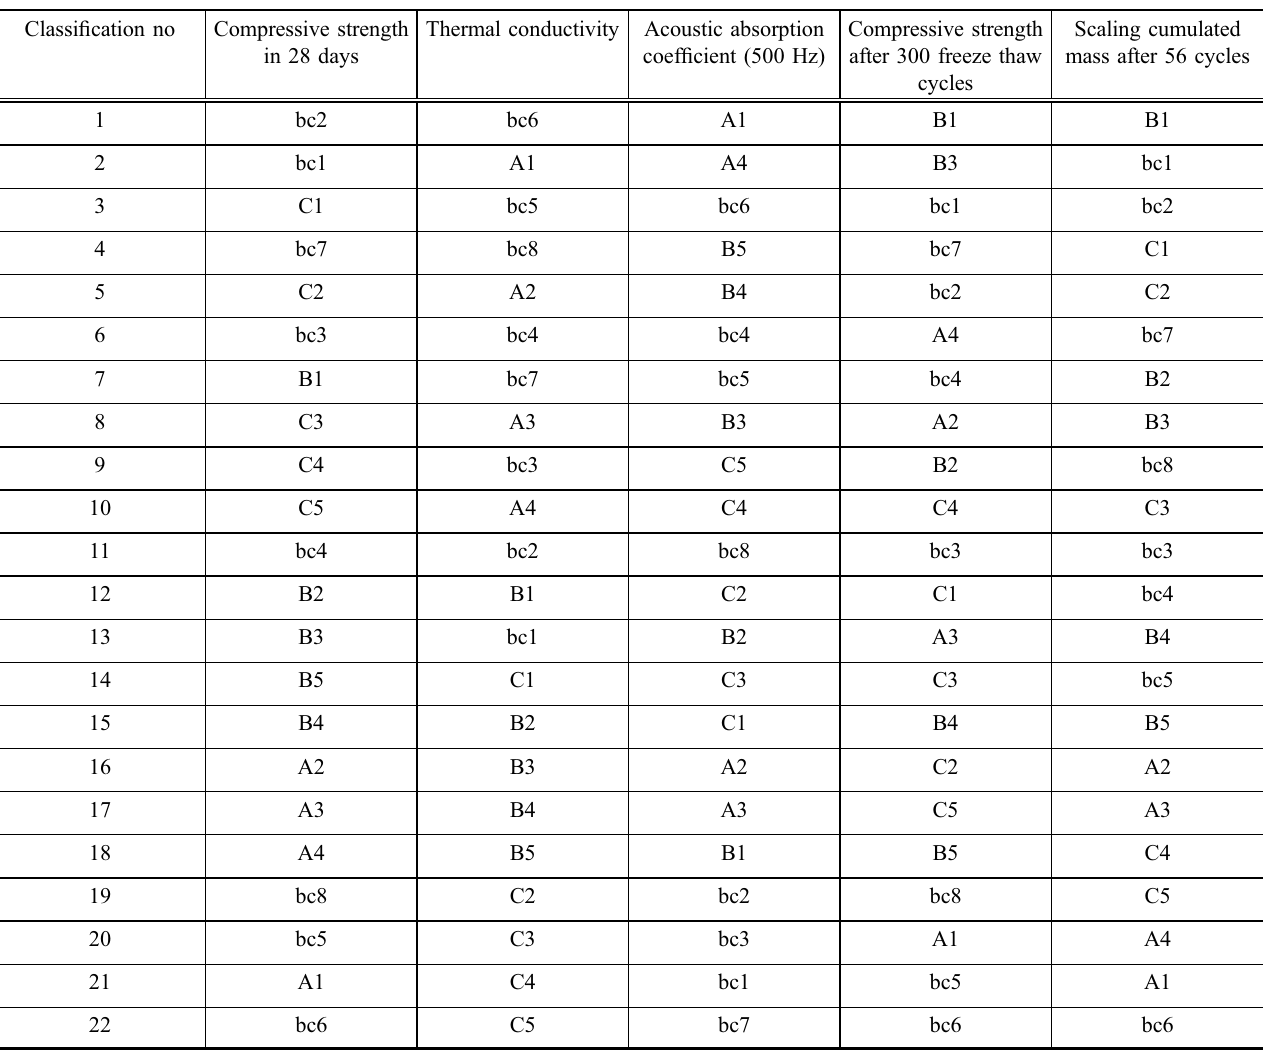
Table 11 Concretes classification according to their respective